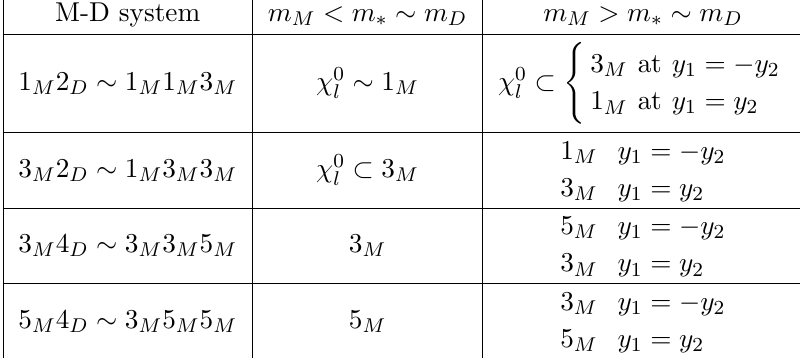
y 2 ) (cid:6) belongs l y 2 ( (cid:17)v ) 2 = 2 m D 1 (cid:0)